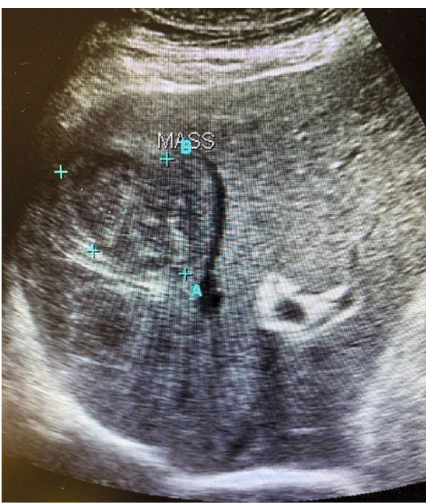
Figure 1: Ultrasound liver showing the heterogeneous mass suggestive of abscess.